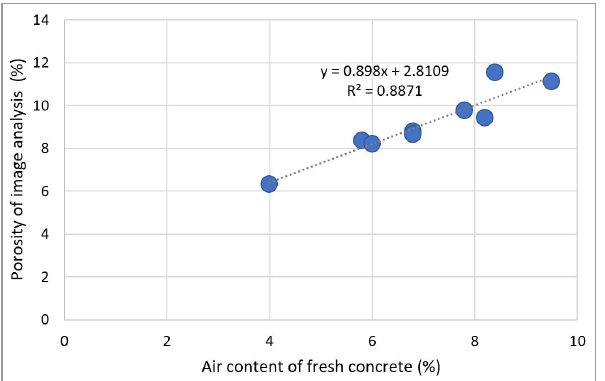
Figure 18. Relationship between the air content of fresh concrete and porosity of hardened concrete.